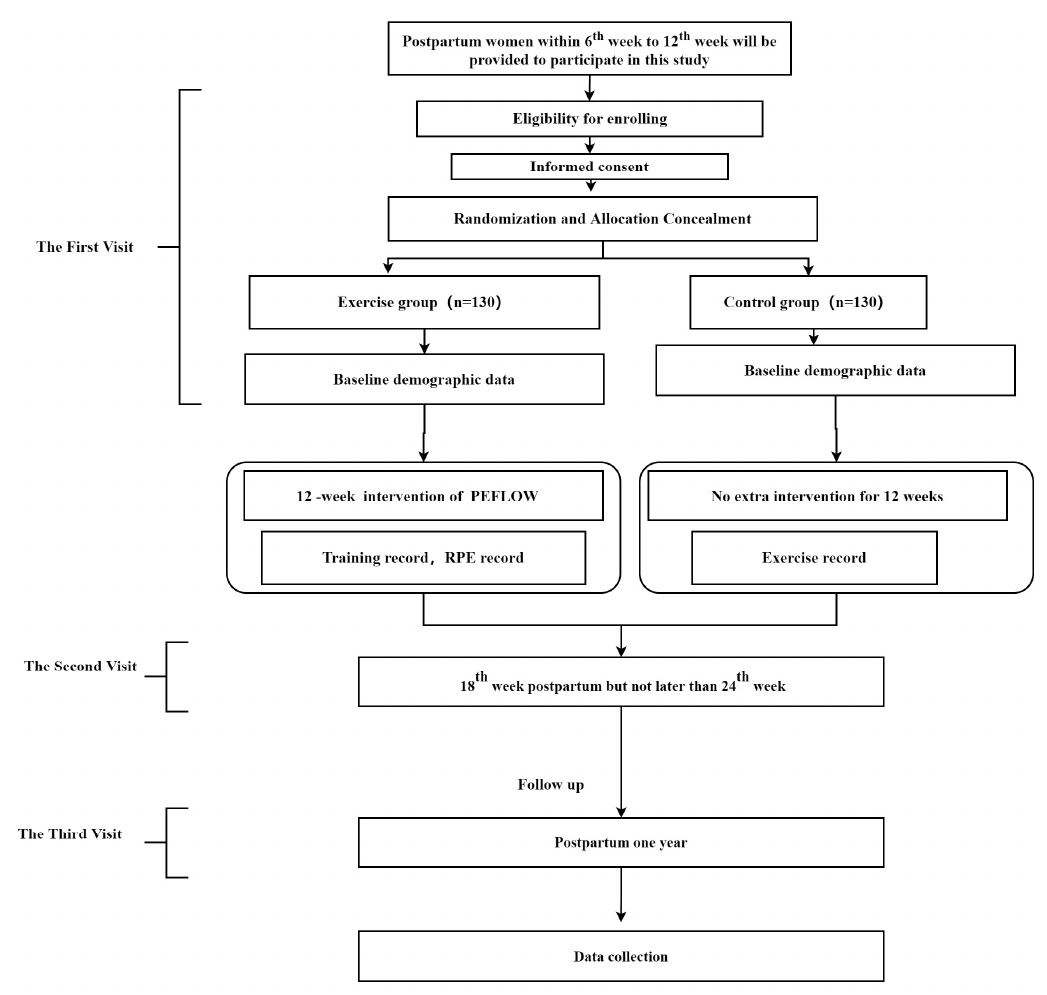
Figure 1. Flowchart of the trial.